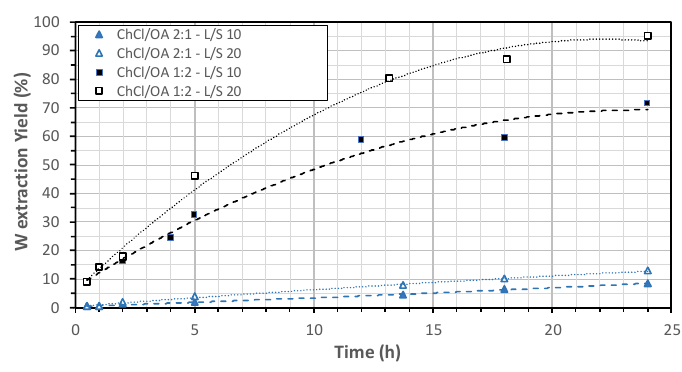
Figure 5. Kinetic experiments at two L/S ratios (10 and 20) at 60 °C.